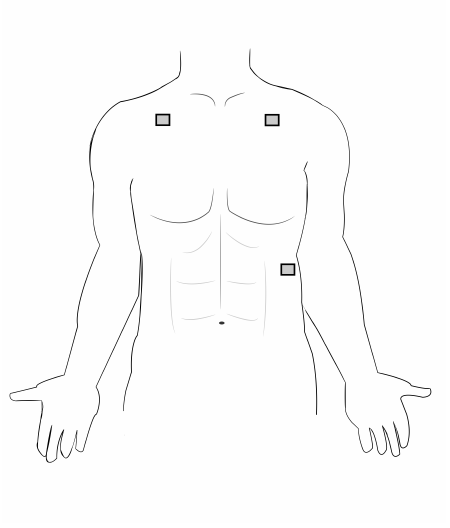
Figure 2. Three-lead positioning for recording of the Electrocardiogram (ECG)